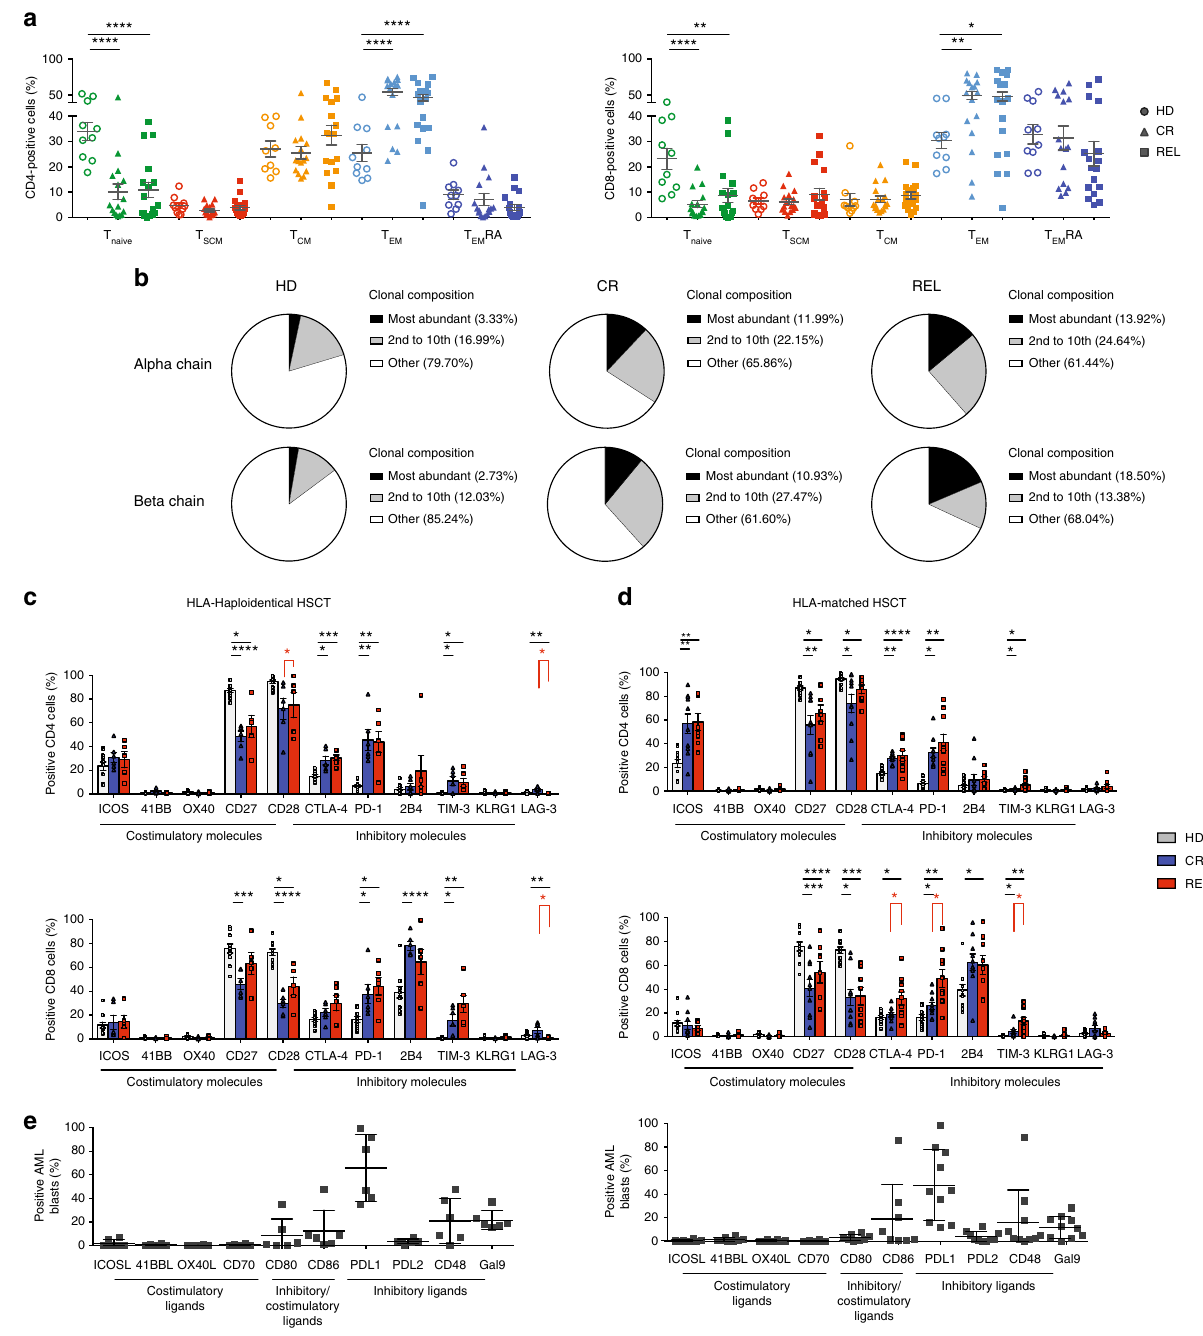
Fig. 1 T-cell subset phenotype in the bone marrow of HSCT patients differs according to the clinical outcome and transplant type. a Proportion of naive (CD45RA + CD62L + CD95 − , T naive ), memory stem (CD45RA + CD62L + CD95 + , T SCM ), central memory (CD45RA − CD62L + , T CM ), effector memory (CD45RA − CD62L − , T EM ) T cells and terminal effectors (CD45RA + CD62L − , T EM RA) over the total CD4 + and CD8 + BM-T-cell subsets in healthy donors (HD, N = 11), in patients who achieved long-term complete remission (CR, N = 16) and in patients who experienced relapse (REL, N = 16) after HSCT. b Pie charts depicting the relative abundance of T-cell clones in each study group (HD, N = 3; CR, N = 3; REL, N = 3) obtained after CDR3 sequencing of both TCR- α and TCR- β chains. c , d Percentages of BM-in fi ltrating CD4 + and CD8 + T cells positive for costimulatory or inhibitory receptors in HLA- haploidentical ( N = 12, c ) or HLA-matched ( N = 20, d ) transplant settings; bone marrow samples from healthy donors were used as controls (HD, N = 11). e Percentages of leukemic blasts at relapse expressing costimulatory or inhibitory ligands in patients receiving HLA-haploidentical (left) or HLA-matched (right) transplants. All the inhibitory receptors have been visualized by means of cell surface staining apart for CTLA-4, visualized after cell fi xation and permeabilization. Individual patient data points, mean, and SEM are shown. Statistically signi fi cant differences between CR and REL groups are highlighted in red, the differences between patients ’ groups and HD in black. * p < 0.05; ** p < 0.01; *** p < 0.001; **** p < 0.0001; nonparametric unpaired two-sided T